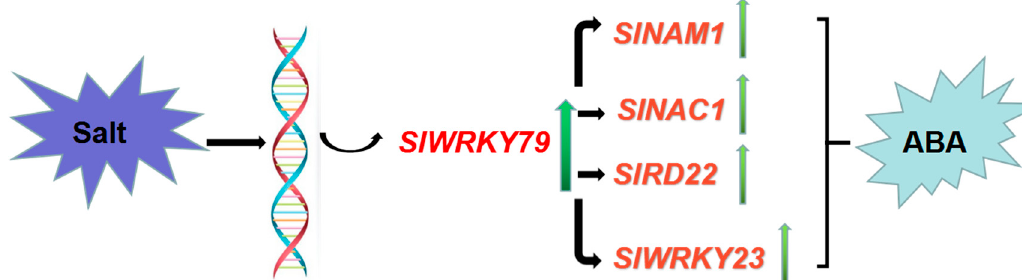
Figure 8. A salt tolerance signaling pathway may be induced by the SlWRKY79 gene.